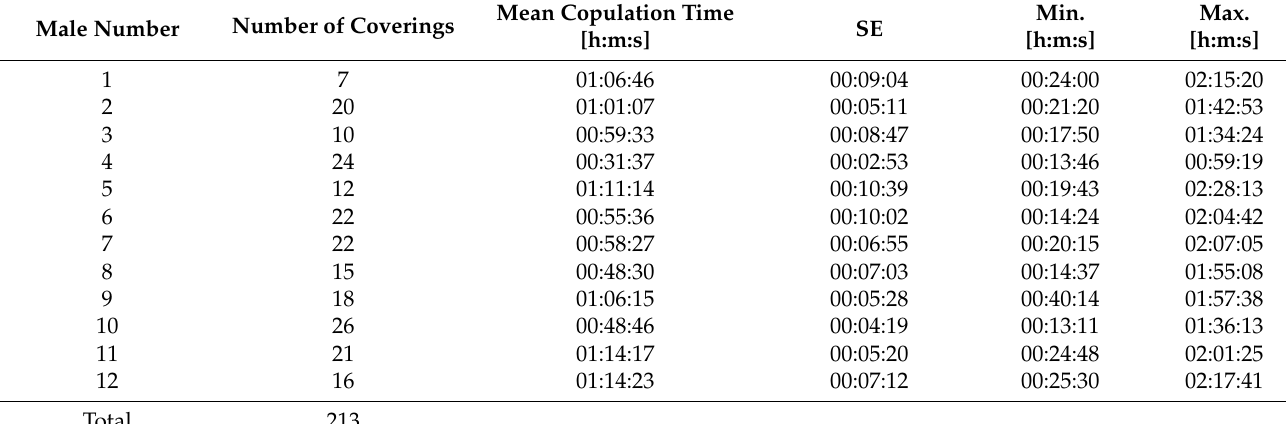
Table 2. Duration and number of copulations of experimental males during the breeding